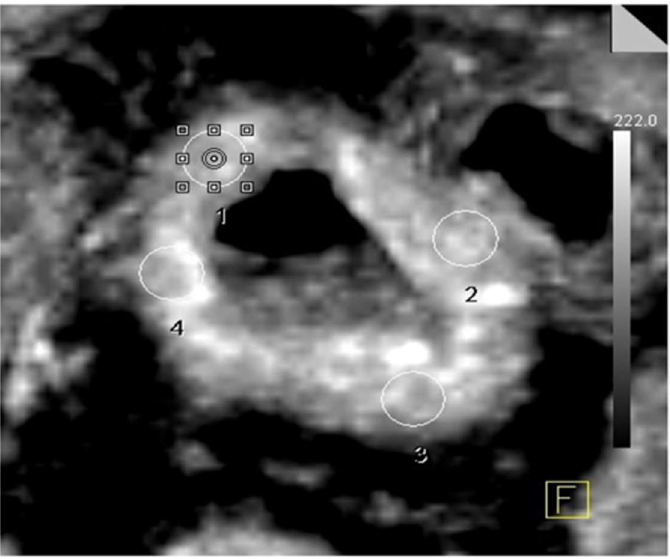
Figure 1. Technique of region of interest (ROI) placement. 1, 2, 3, and 4 represent the ROIs placed on the anterior, lateral, posterior, and medial walls, respectively, on the axial section of the involved bowel loop.